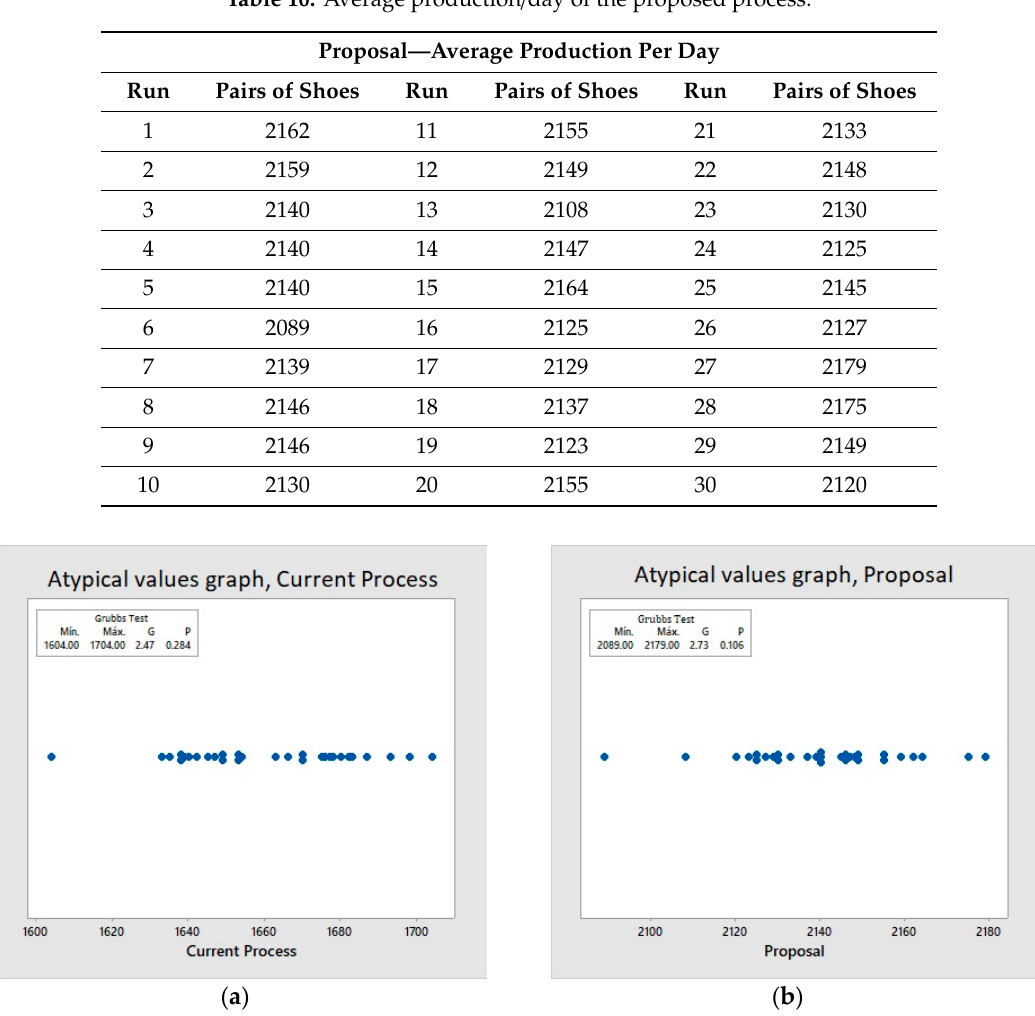
Figure 11. Grubbs test ( a ) Atypical values, current process. ( b ) Atypical values,